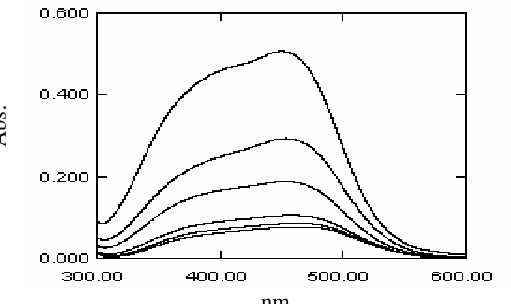
Figure 2. UV-Visible spectra of different concentrations of Bismarck brown G.